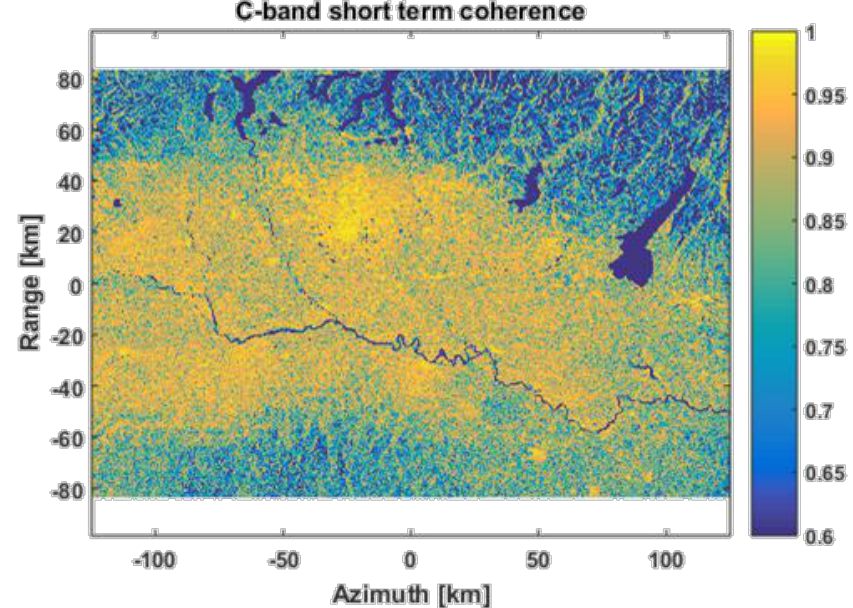
Figure 25. GEO SAR C-band simulation. Coherence between the reference image, shown in Figure 21, and the image affected by clutter, shown in Figure 22. The interferometric revisit is 900 s, see Table 1.